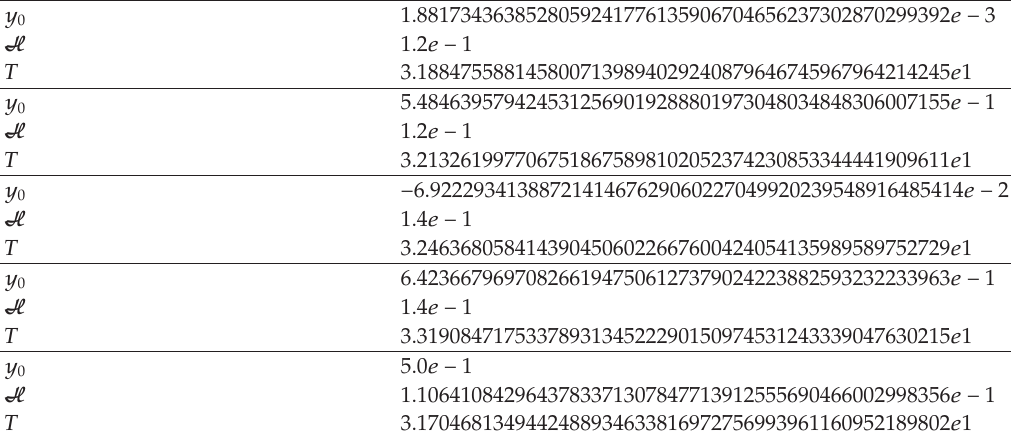
Table 2: Corrected values up to 50 digits for the selected orbits in Figure